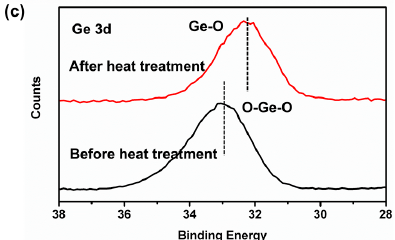
Figure 3. X-ray photoelectron spectroscopy (XPS) spectra of ( a ) Ni 2p, ( b ) O 1s and ( c ) Ge 3d for the as-prepared samples.